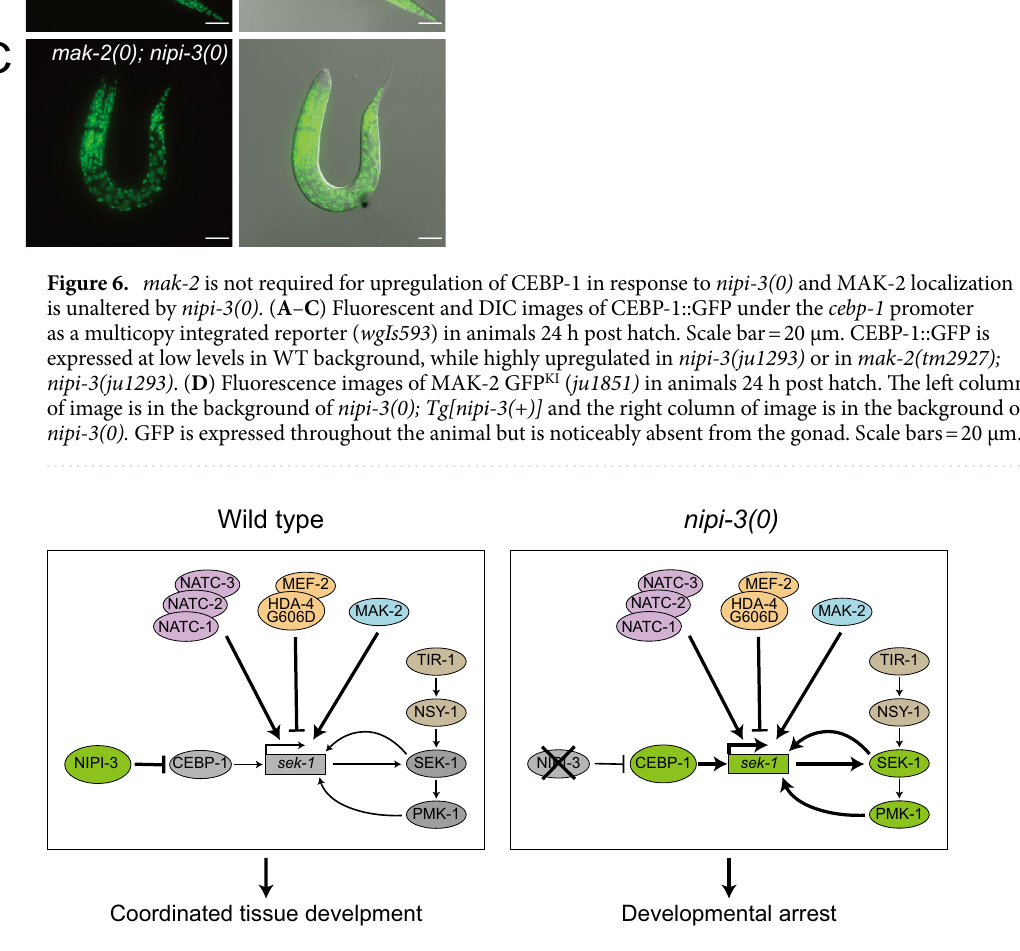
Figure 7. Hypothesis of signaling downstream of NIPI-3/Tribbles. A number of regulators downstream of NIPI-3 influence sek-1 transcriptional regulation. The NATC complex natc-1/2/3 and HDAC hda-4 are identified as novel components in the control of animal development in this study. Furthermore, positive feedback mechanisms of mak-2, pmk-1, and sek-1 forms a complex pathway to regulate proper animal development. The findings on the nipi-3(0) background led us to the wild-type scenario. See main text for